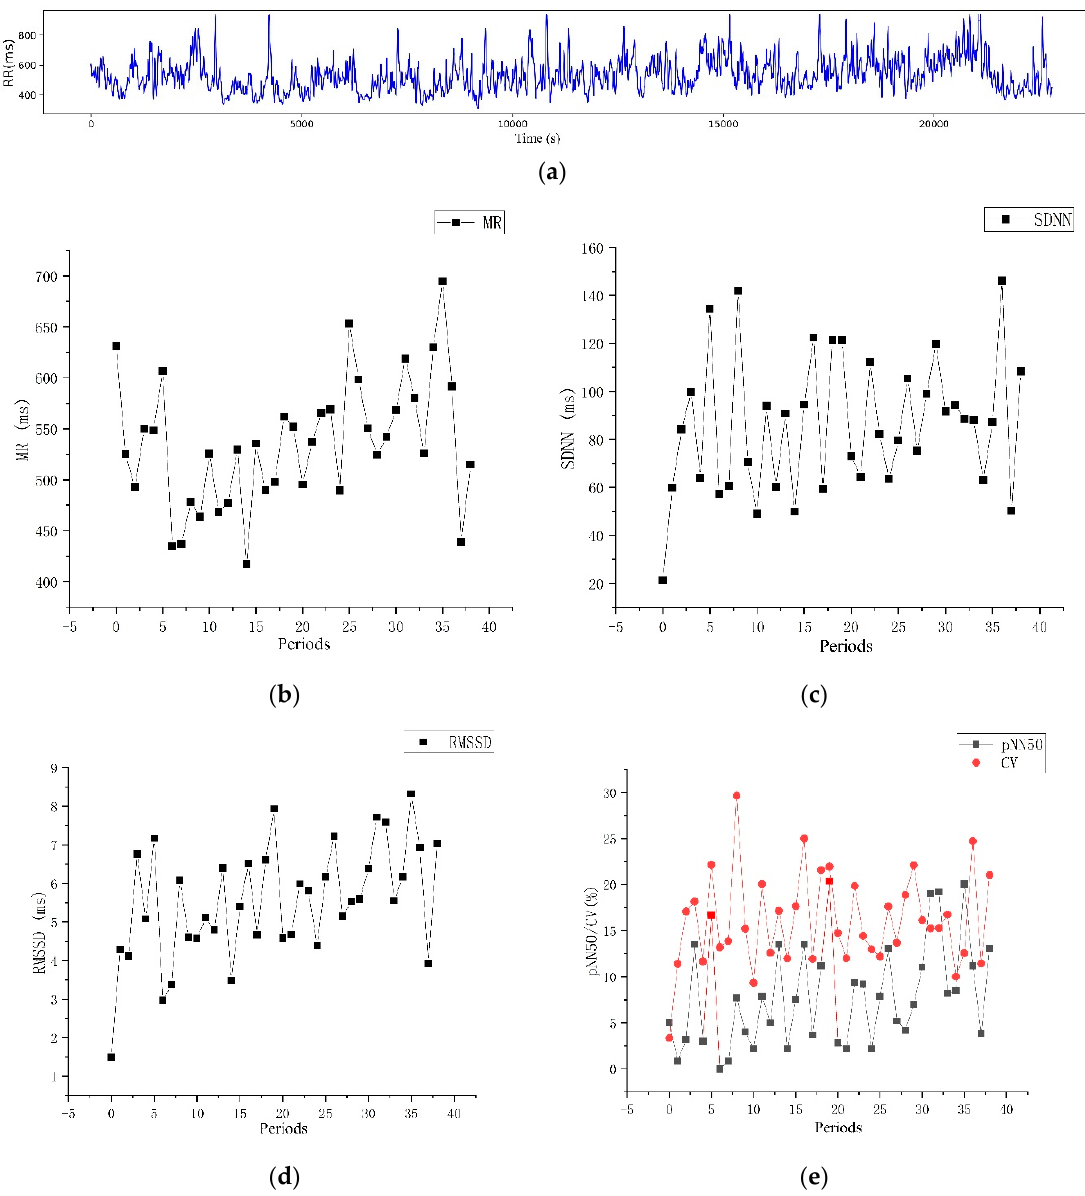
Figure 10. Time-domain index change trend chart. ( a ) Description of time interval between two adjacent R waves (RR) intervals. ( b ) Description of mean value of RR i (MR). ( c ) Description of standard deviation of RR i . (SDNN). ( d ) Description of adjacent RR intervals (RMSSD). ( e ) Description of pNN50 and coefficient of variation (CV).